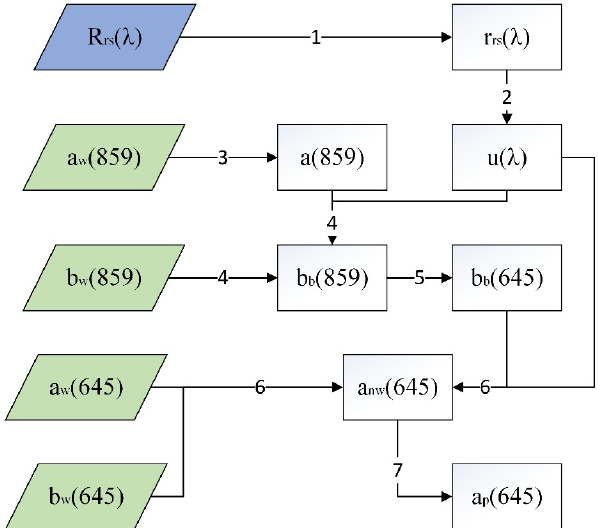
Figure 2. Flow chart of the estimation method of particle absorption at 645 nm.